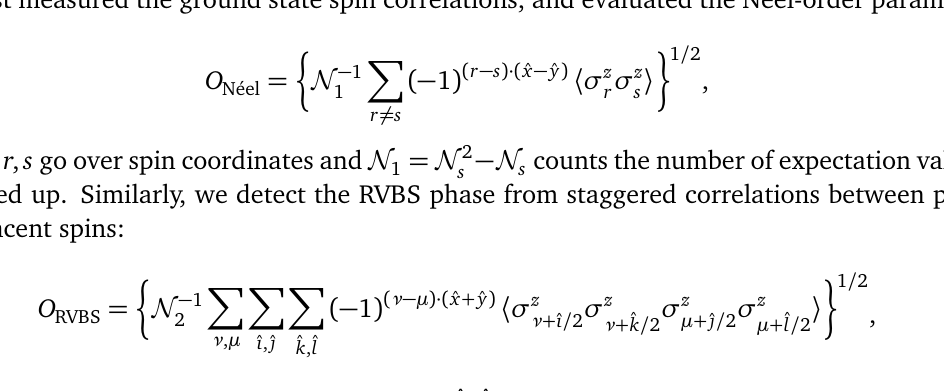
Figure 4: Order parameters (a) O phase, plotted over the coupling parameter λ for system sizes L (yellow), 24 × 8 (orange) and 30 × 10 (black). The vertical line indicates the location of λ from [ 29 ] c